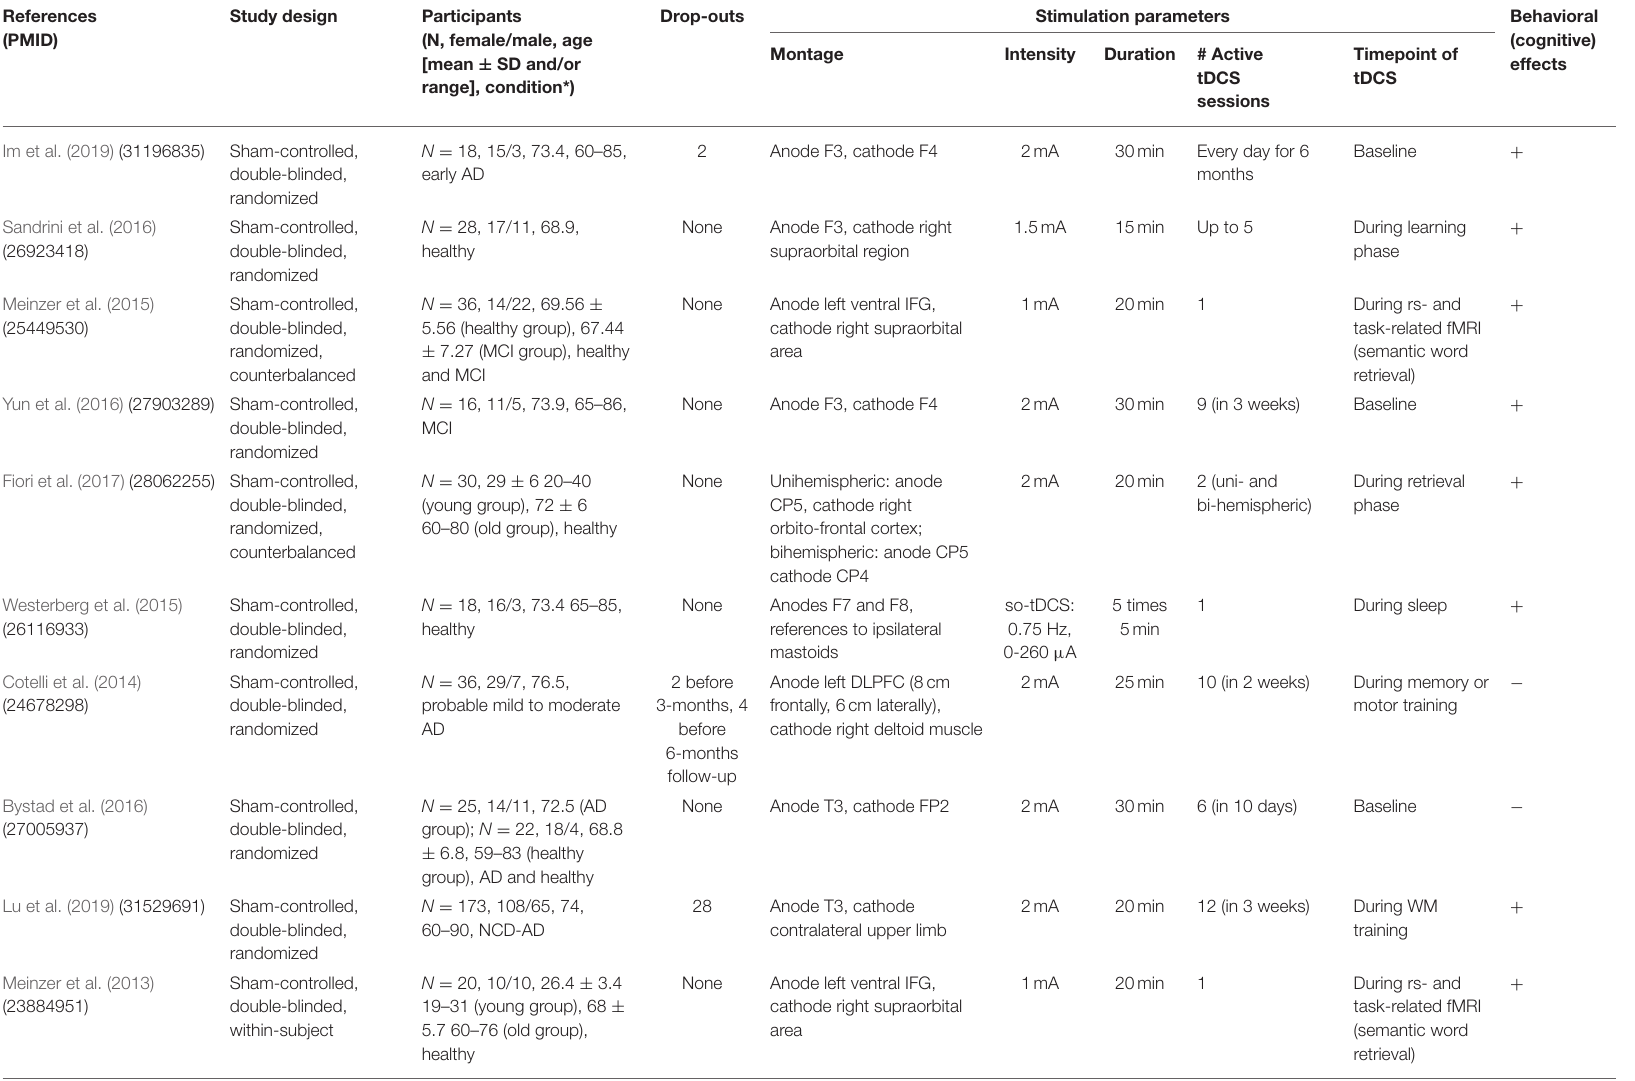
TABLE 2 | Summary of all studies reviewed including most important features and tDCS